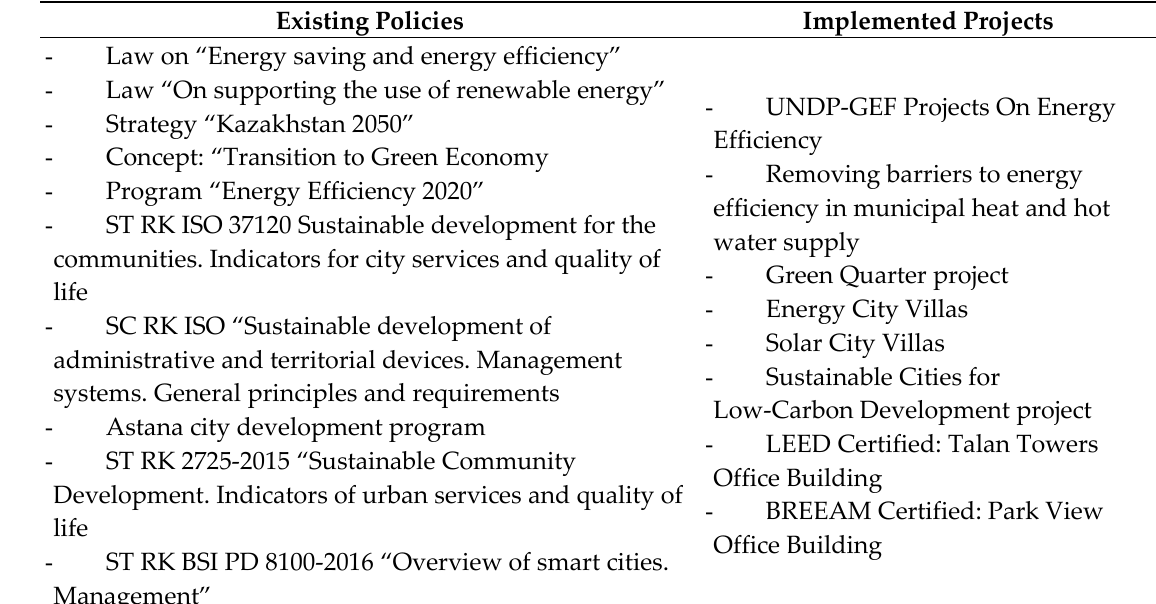
Table 1. Existing policies and